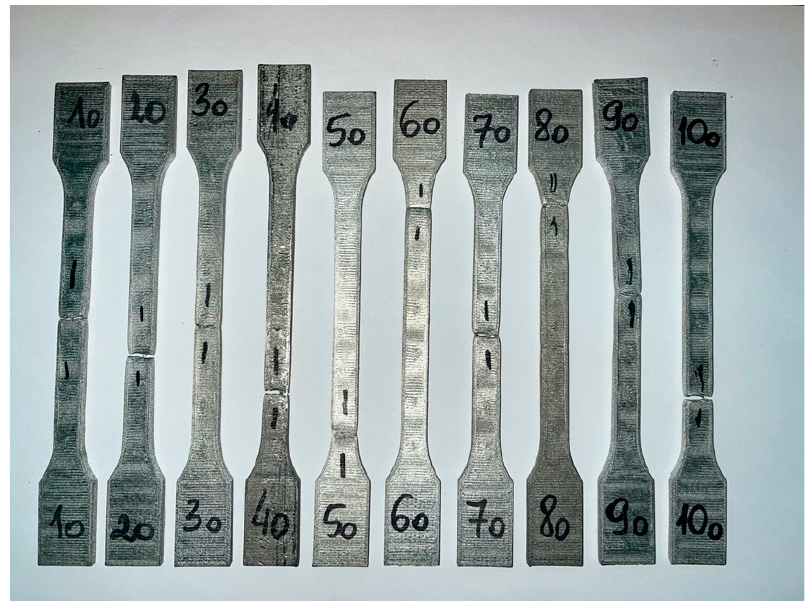
Figure 16. Tested samples with lamination angle 90 ◦ and envelope. Displacements in samples measured by the extensometer were read from raw data tables, which, due to their length, will not be mentioned in the following text. When it comes to Poisson’s ratio, it was calculated from Formula (1). Dimensions of samples with lamination angle 0 ◦ and 90 ◦ without envelope are sum- marized in Tables 5 and 6. Table 5. Measurements results of samples with lamination angle 0 ◦ .